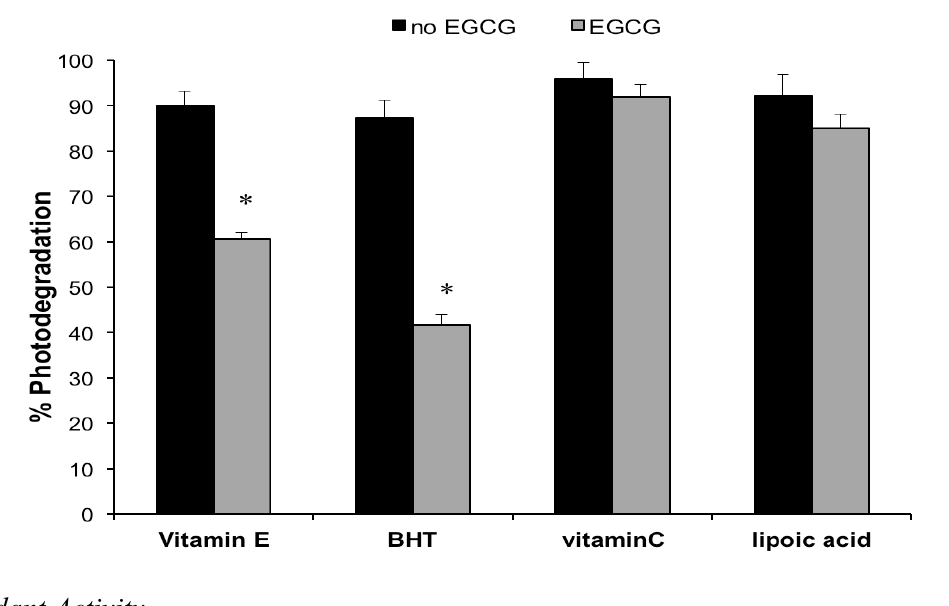
Figure 4. Photodegradation (%) of the co-antioxidants, vitamin E, BHT, vitamin C or   -lipoic acid in their formulations withouth or with EGCG (1%), after 1 h irradiation with the solar simulator. Values are means ± S.D. of at least six experiments. * p < 0.05 ( t